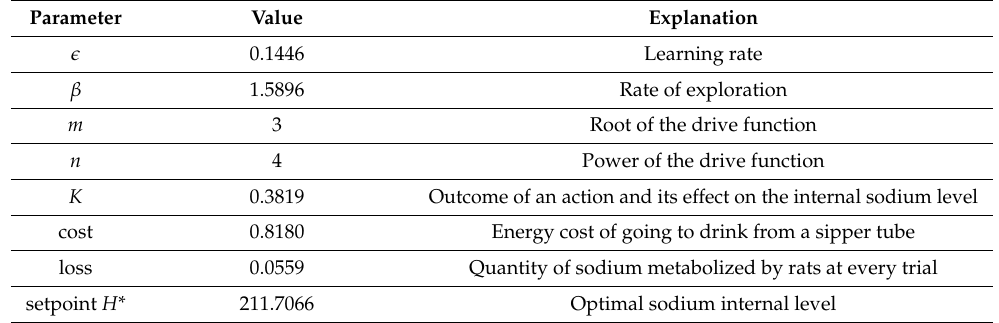
Table A1. Free parameters of the model and their